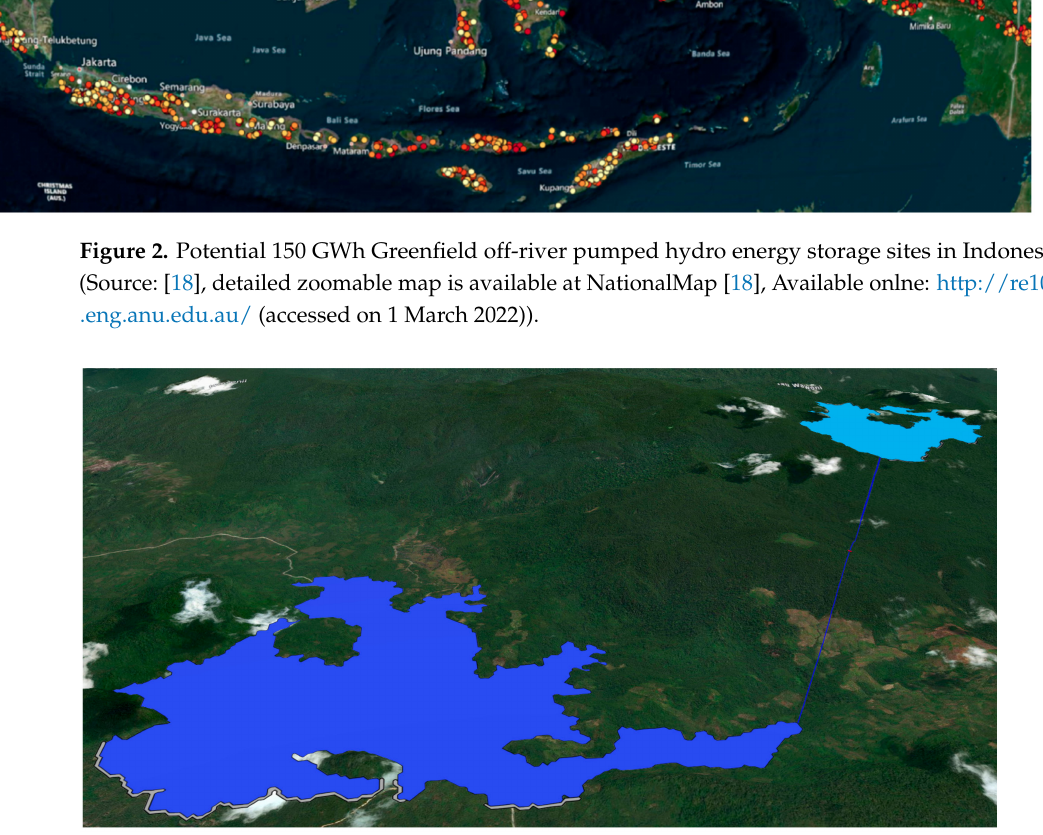
Figure 3. Potential 150 GWh Greenfield off-river pumped hydro energy storage site on Wowonii island near Sulawesi. The upper and lower reservoirs are light and dark blue, respectively. Head: 609 m; separation of reservoirs: 5 km; volume of water: 122 GL (0.8 GL per GWh); com- bined reservoir area: 1100 Ha (7 Ha per GWh). Latitude/Longitude: 4.21056 ◦ S, 123.08990 ◦ E. Image from NationalMap [18] and original data from the Australian National University Global Pumped Hydro Atlas